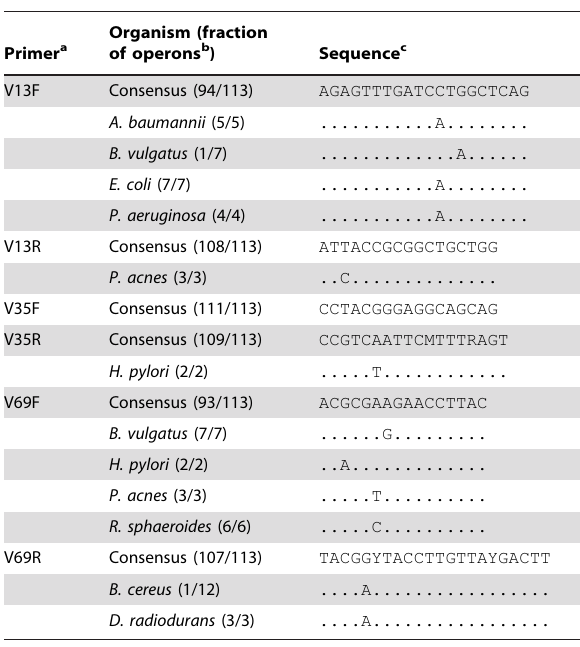
Table 3. The primer sequences used to amplify the three regions of the 16S rRNA gene and their homology to the 16S rRNA gene sequences represented in the mock community.